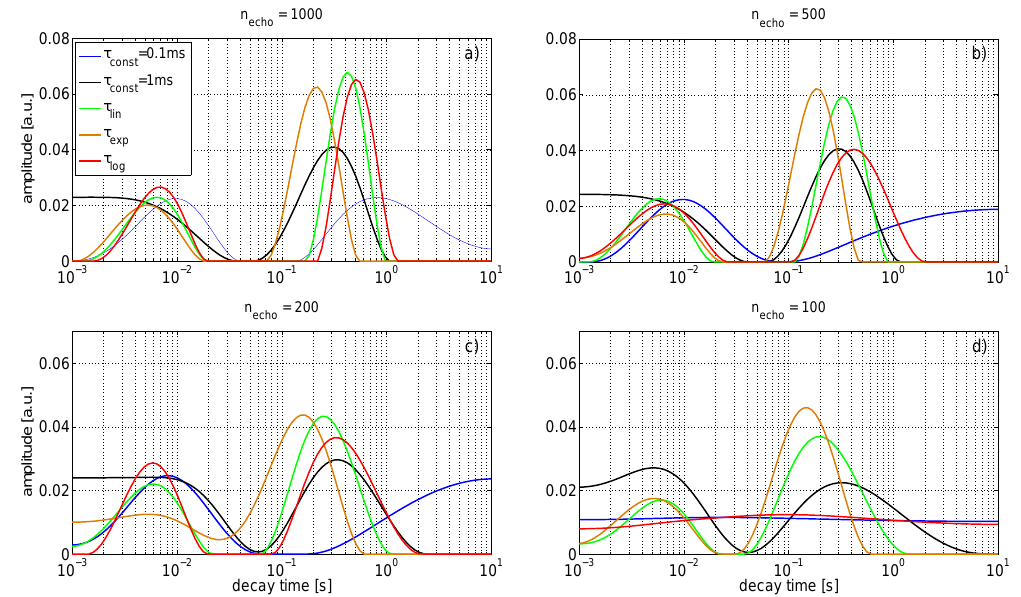
Fig. 5. T 2 distribution of a bi-exponential signal with T 2 , 1 =0.01s and T 2 , 2 =1s with a diffusion component added and 5% noise. CP- MGs with linearly increasing, exponentially equidistant and logarithmically equidistant τ spacing with τ max =2ms are plotted for different amounts of echos. Additionally, two sequences with an constant τ spacing are